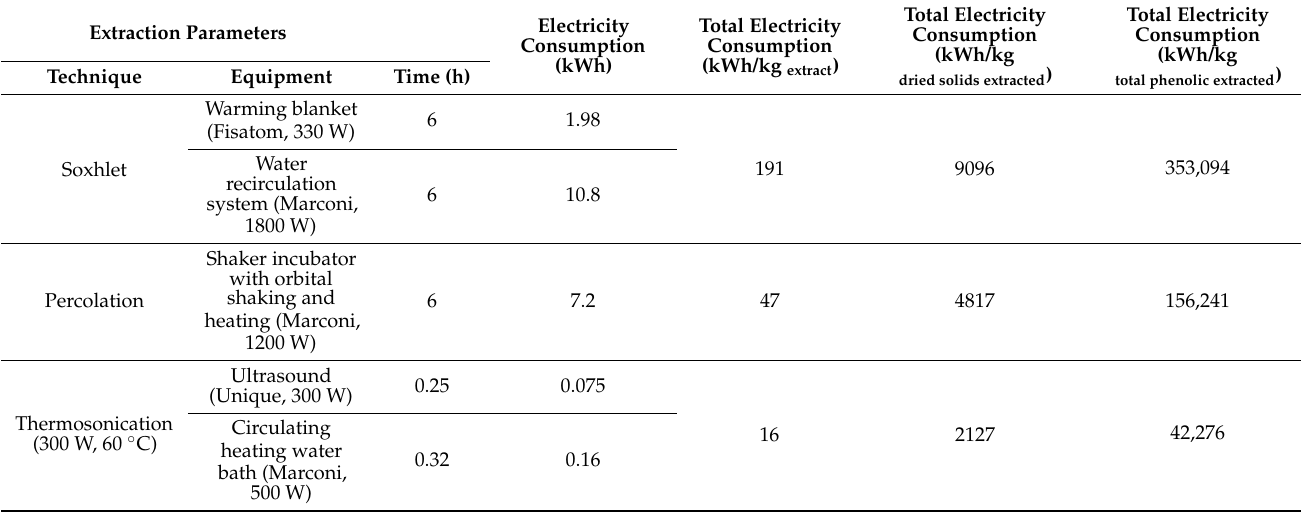
Table 3. Electricity consumption to obtain fennel extract, dried fennel solids, and fennel total phenolics.